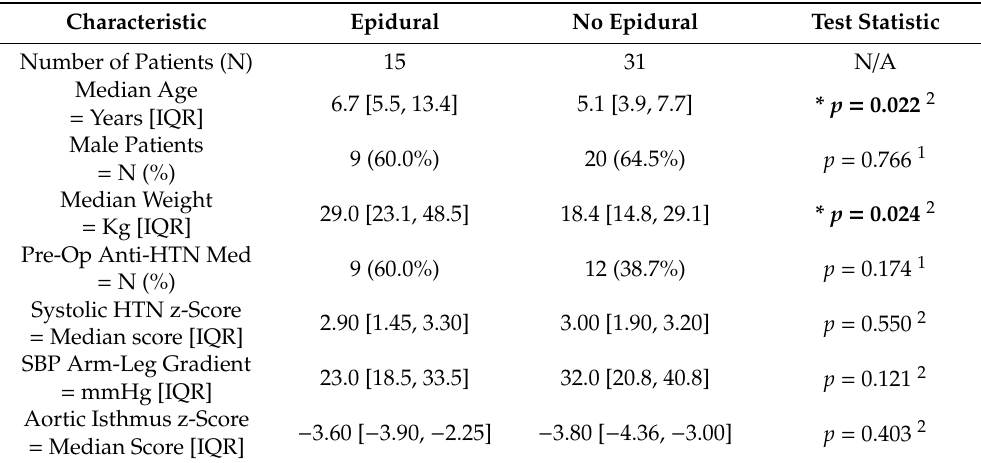
Table 1. Baseline